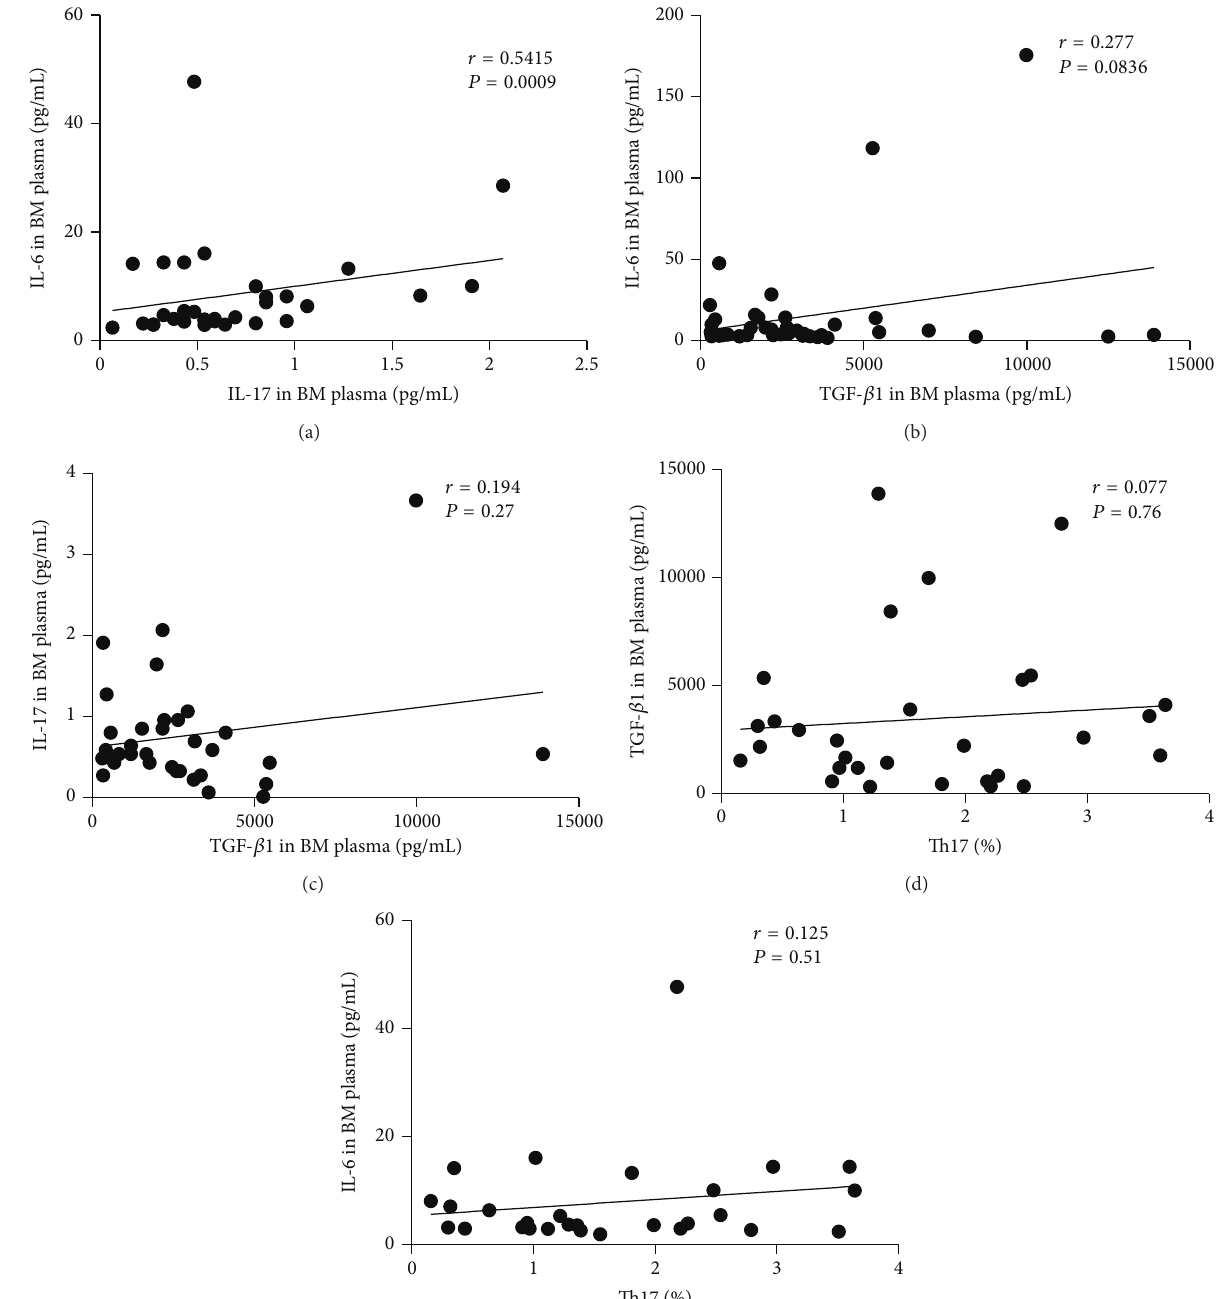
Figure 5: Correlations between the related cytokines in ND AML patients. (a) A positive correlation was found between IL-6 and IL-17A concentration ( 𝑟 = 0.5415 , 𝑃 = 0.0009 ) in ND AML patients. (b) Marginal correlation existed between TGF- 𝛽 1 and IL-6 concentration ( 𝑟 = 0.277 , 𝑃 = 0.0836 ). (c, d, e) No significant correlation was found between TGF- 𝛽 1 and IL-17A, Th17 and TGF- 𝛽 1, or Th17 and